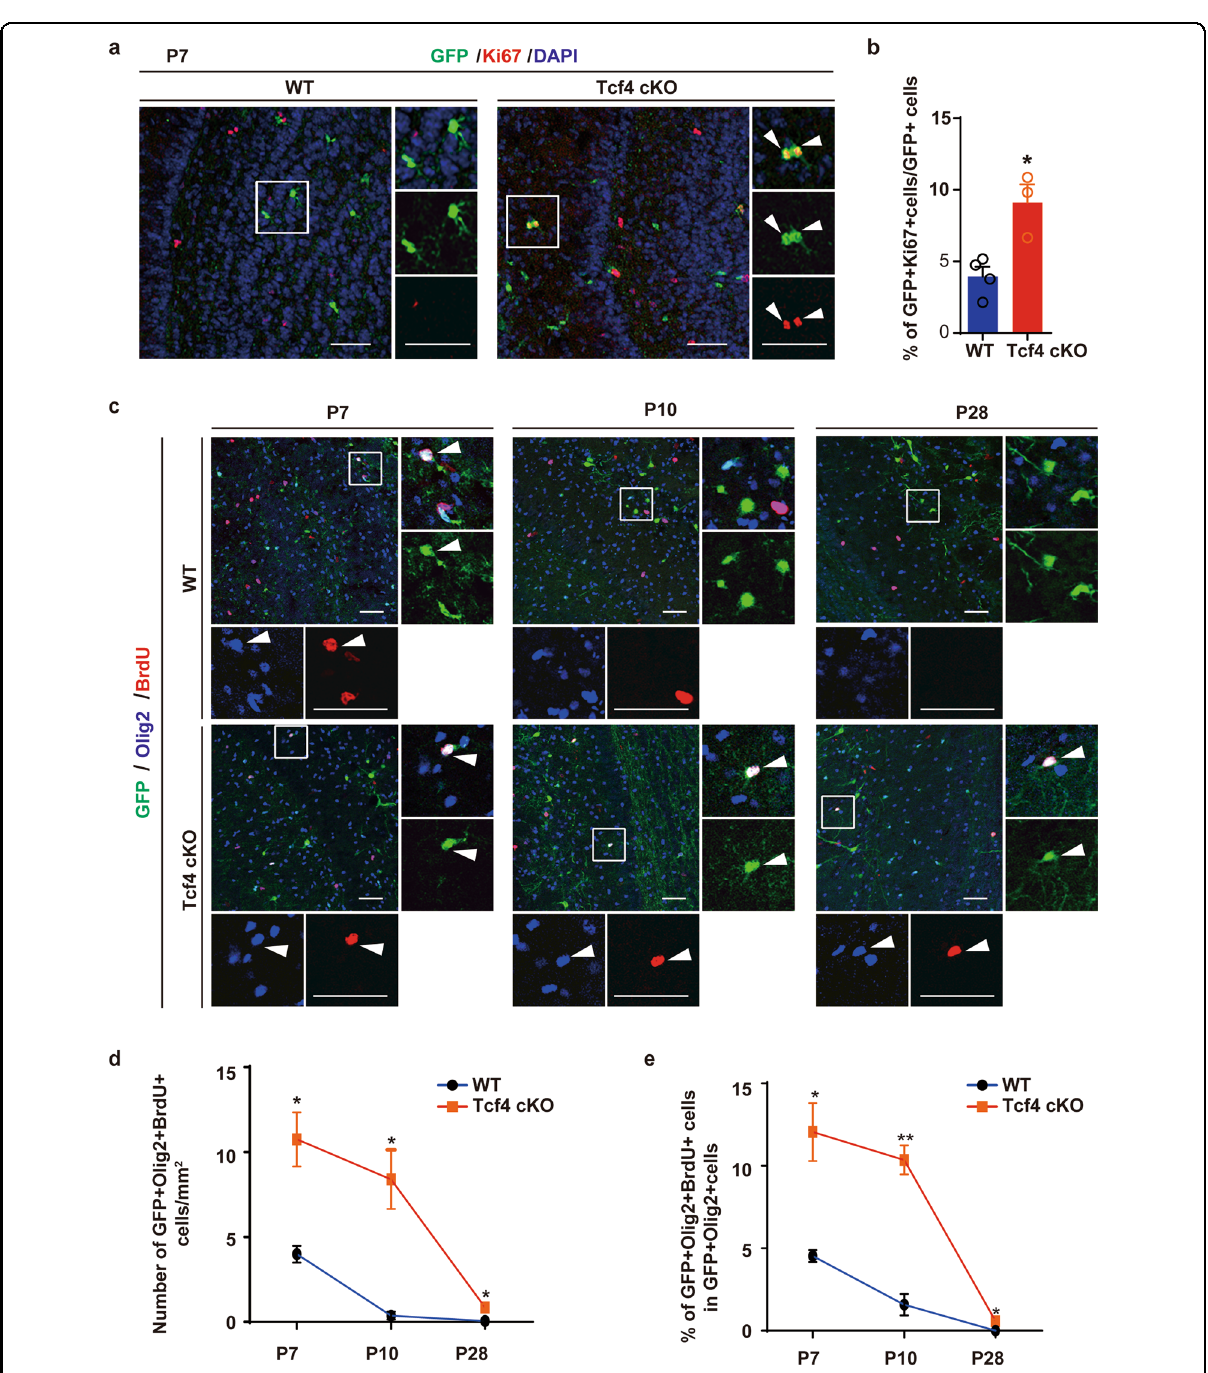
Fig. 6 Proliferation of OPCs in Tcf4 cKO OB. a Sections of OB from WT and Tcf4 cKO stained for GFP and Ki67 at P7. Scale bar: 50 μ m. b Quanti fi cation of proliferating OPCs in both WT and Tcf4 cKO OBs. Student ’ s t test was used to compare two groups. Data are presented as mean ± SEM. * p < 0.05. At least three samples were analyzed for each genotype. c Representative images show sections of OB from WT and Tcf4 cKO stained for Olig2 and BrdU at P7, P10, and P28. Arrowheads indicate proliferating OPCs which are BrdU-positive. Scale bar: 50 μ m. d , e Quanti fi cation of the density of proliferating OPCs ( d ) and the number of proliferating OPCs derived from the Nkx2.1 lineage ( e ). Student ’ s t test was used to compare two groups. Data are presented as mean ± SEM. * p < 0.05, ** p < 0.01. At least three OBs were analyzed for each genotype at each time